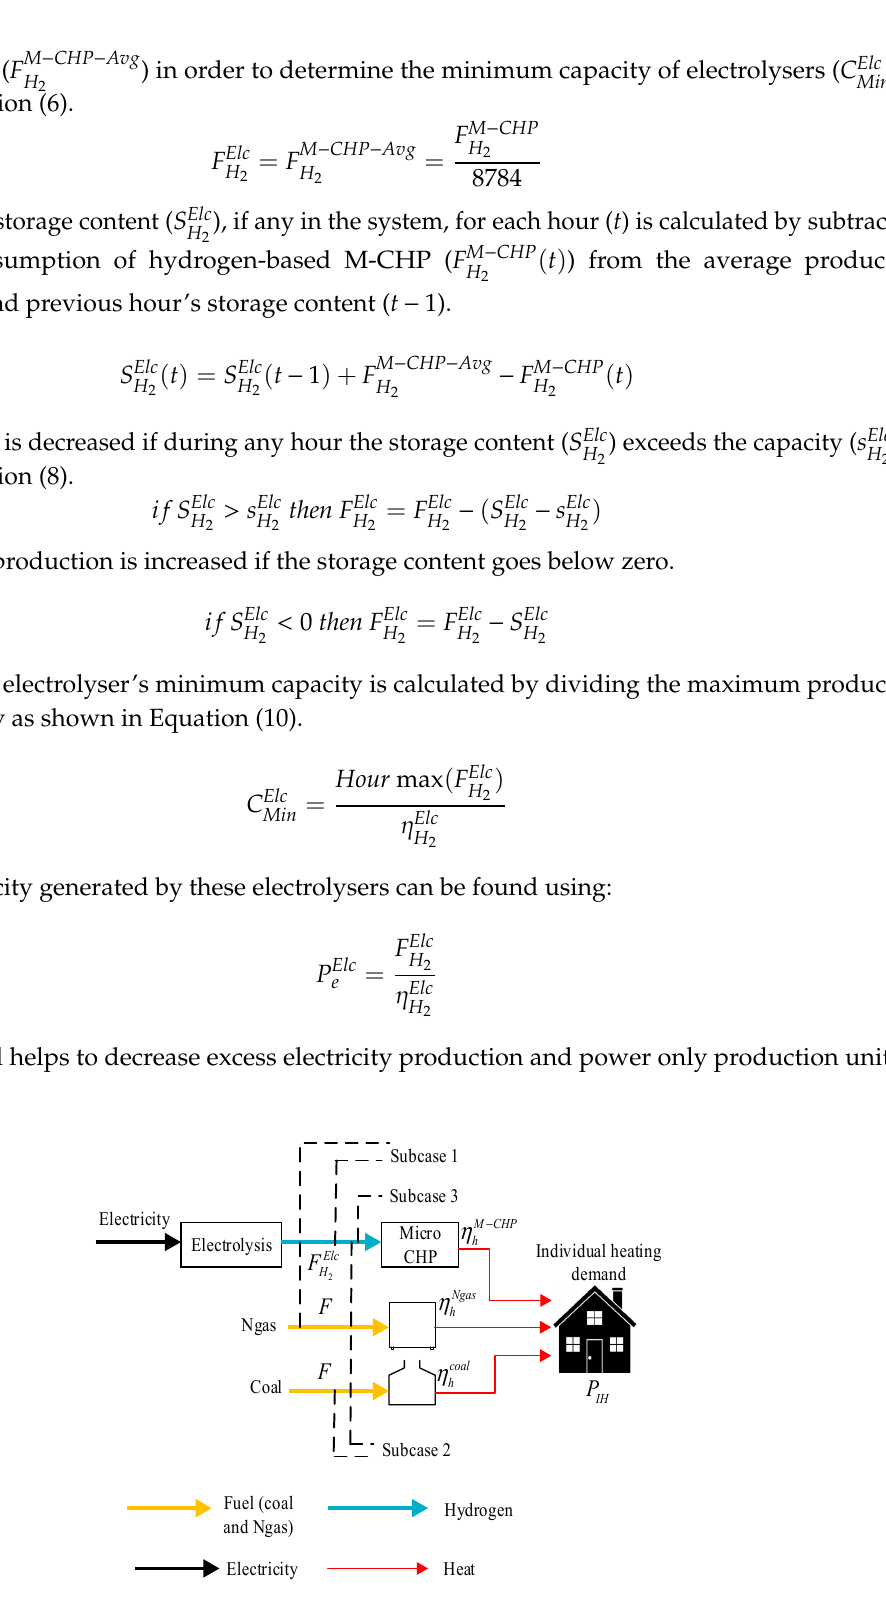
Table 2. Summary of Different Cases of Individual Heating Infrastructure.